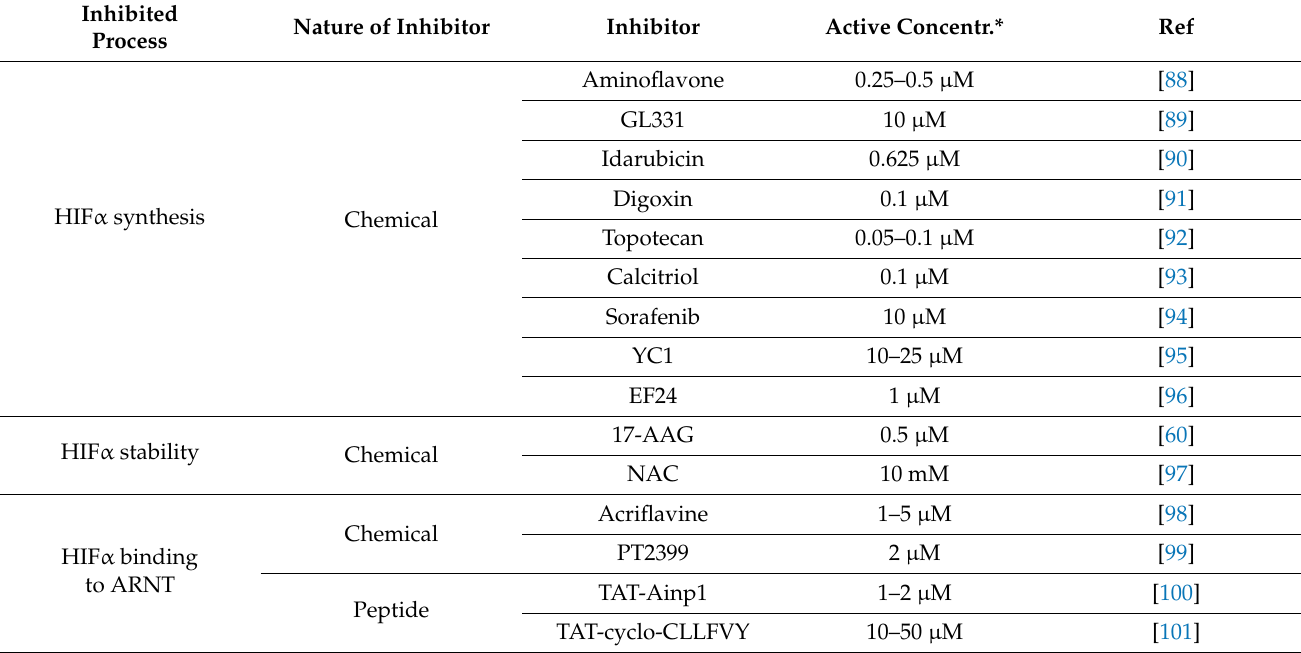
Table 1. Chemical and peptide or peptidomimetic inhibitors of HIFs discussed in this article.